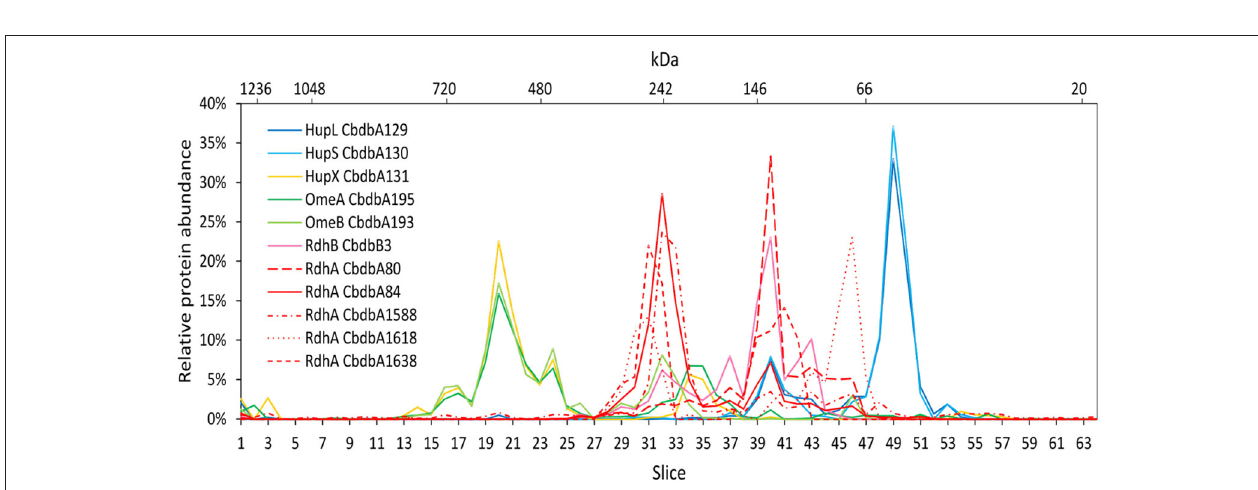
FIGURE 4 | Relative abundance of proteins associated with the OHR complex across the length of a blue native gel cut into 64 slices after disrupted cell DDM extraction (protein extraction mode 3). The color code is the same as used in Figure 1 . Different RdhA proteins are shown with different line types.